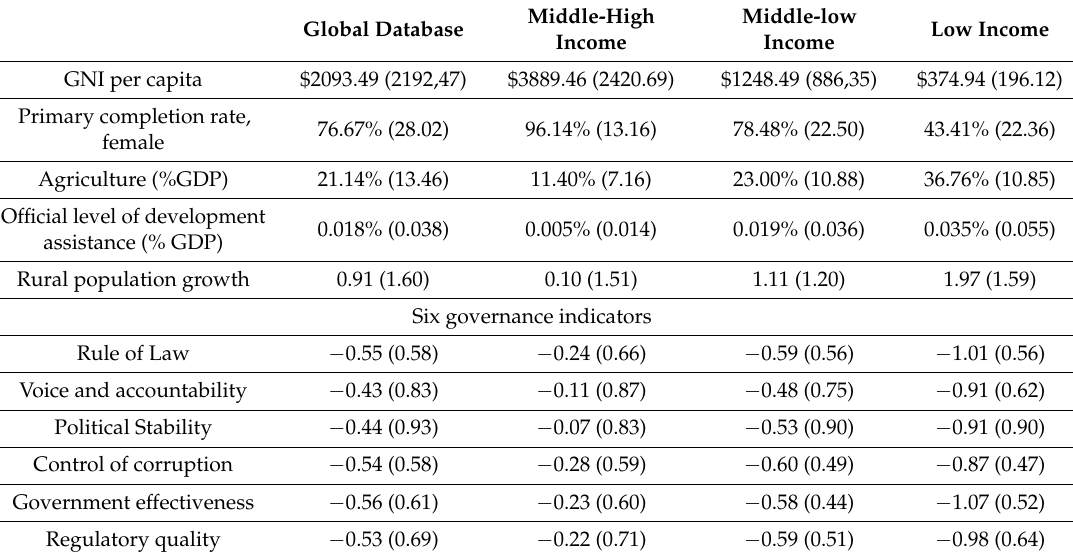
Table 1. Explanatory variables used in the